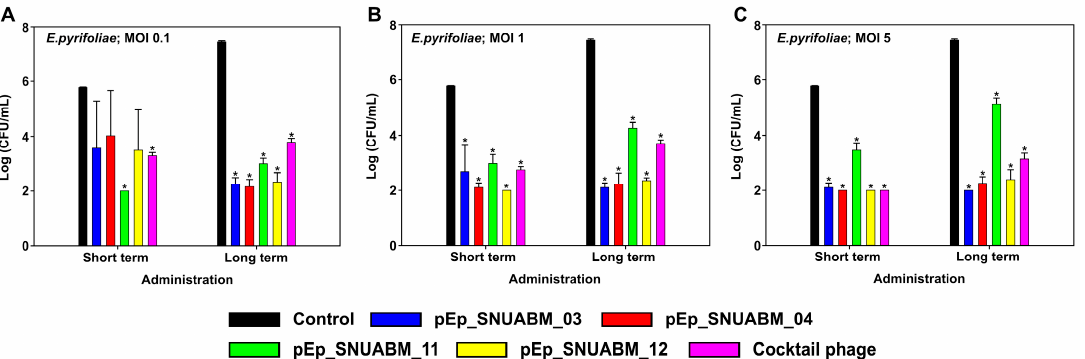
Figure 8. Evaluation of antibacterial activity of phages on Erwinia pyrifoliae. The assay was performed at an MOI of 0.1 ( A ), 1 ( B ), and 5 ( C ). Statistical significance was determined using a one-way analysis of variance (ANOVA) with Holm-Sidak tests ( p < 0.001).